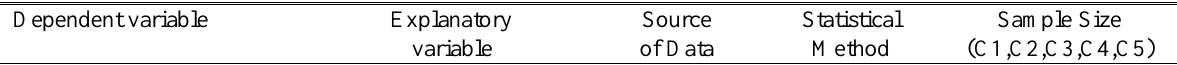
Table A1.1 Summary of statistical analyses performed. Variables in italics are continuous variables; all other variables are